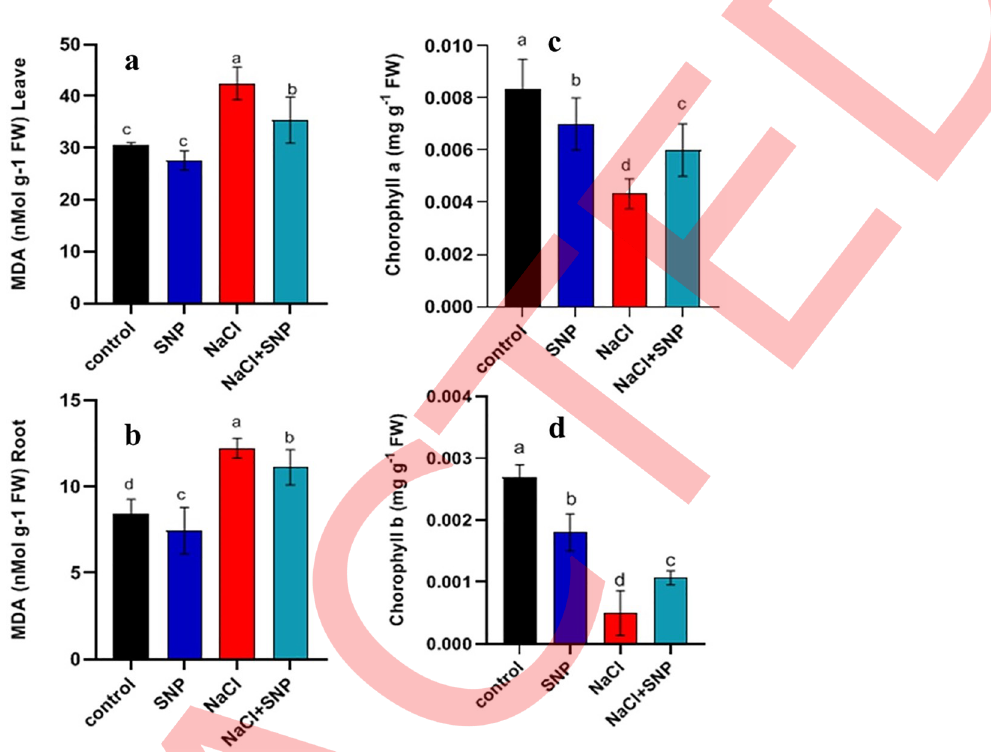
Fig 1. Analysis of MDA content in leaves and roots (a, b) and chlorophyll contents (c, d) of treated and control plants of soybean. Data are means ± SD calculated from three